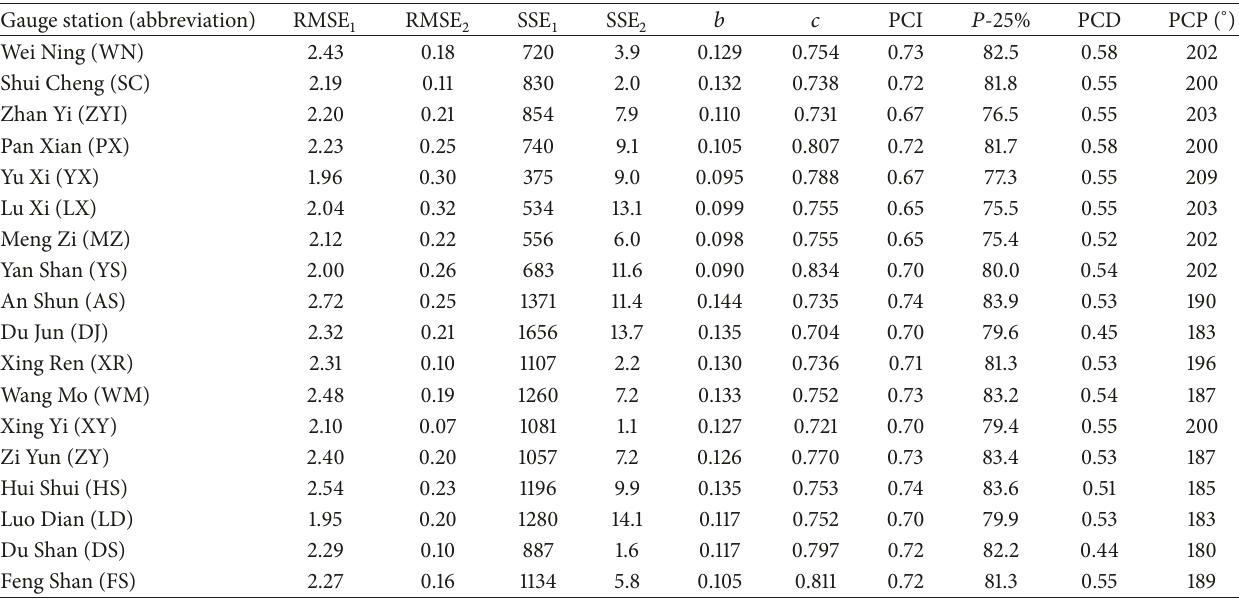
Table 2: Values of RMSE and SSE for (1) and (2), the values of constants 𝑏 and 𝑐 in the exponential curves of (2), the PCI, the percentage of precipitation contributed by the top 25% of rainy days ( 𝑃 -25%), and PCD and PCP for each station.